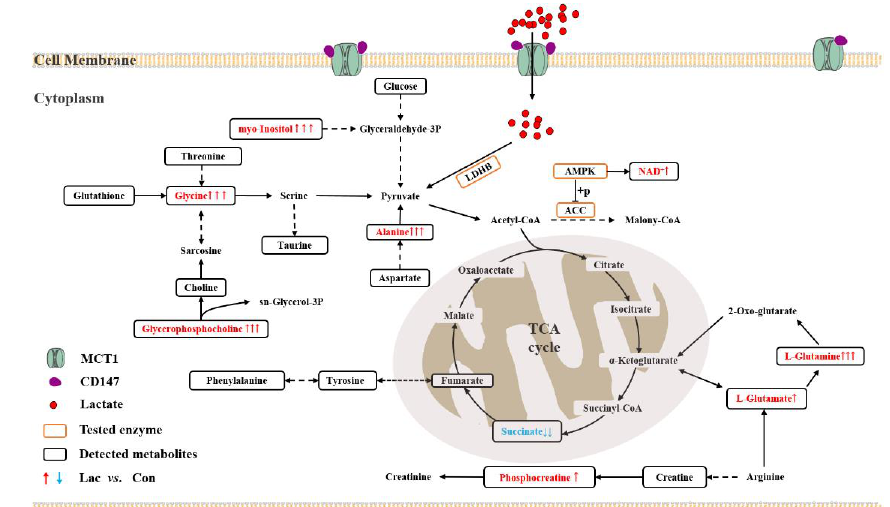
Figure 9. Overview of the metabolic mechanisms accounting for the effects of lactate treatment on the proliferation and differentiation of myoblasts based on KEGG metabolic pathways. The dotted arrow indicates multiple biochemical reactions; the solid arrow denotes a single biochemical reaction. The metabolites without frame refer to undetected metabolites.